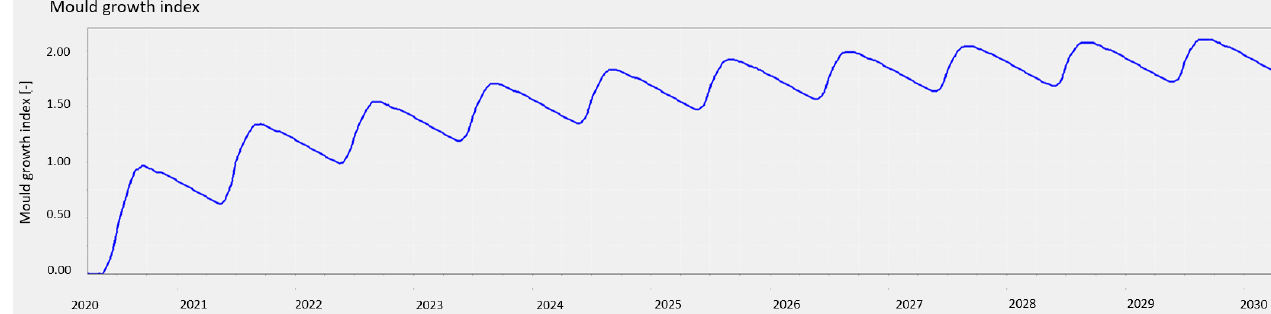
Figure 12. Graph showing mould growth result and mould index for the outside surface of the pli ‐ able membrane within the 40 mm air cavity layer of the 7 ‐ star clay masonry veneer wall with a vapour ‐ permeable membrane—western orientation.